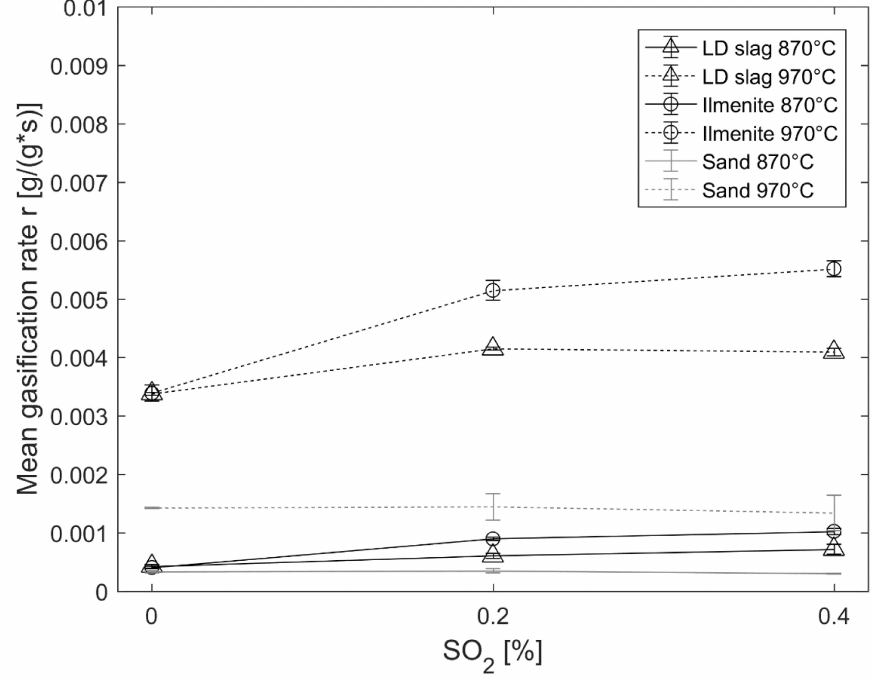
Figure 7. Mean gasification rate “r” between 0.3 < X c < 0.7 for LD slag, ilmenite, and sand at different temperatures and concentrations of SO 2